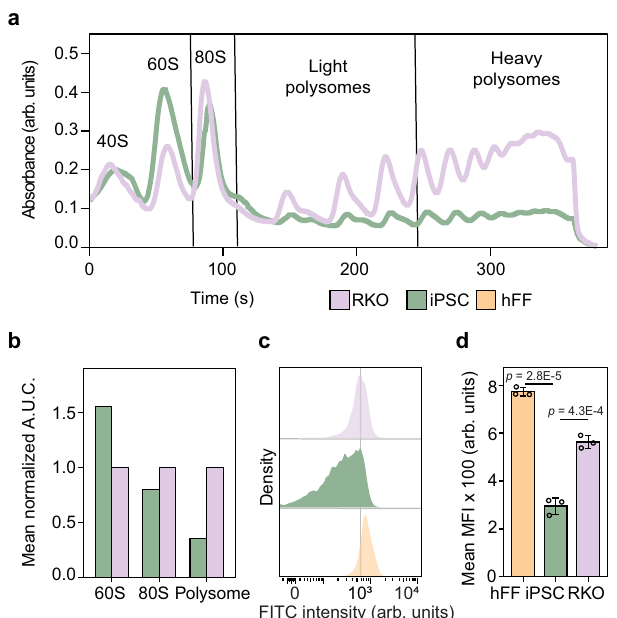
Fig. 4 iPSCs have lower polysome content and protein synthesis rate than differentiated cells. a Ribosome density pro fi le on a 10 – 50% sucrose gradient of hi12 iPSC lysates against that of RKO cells. b Analysis of the area under the curve (A.U.C.) of several fractions of the ribosome pro fi le ( n = 2 biologically independent samples). c Measurement of OPPuro incorporation in hi12 iPSC, hFF, and RKO. The gating strategy is described in Supplementary Fig. 6k. d Analysis of mean fl uorescence intensity (MFI) from OPPuro incorporation in hi12 cells, hFFs and RKO cells ( n = 3 biologically independent samples for each cell line). P -values were calculated using a two-sided Student t -test. p < 0.05 were considered as signi fi cant. Error bars represent ±the standard deviation of the mean. Source data are provided as a Source Data fi